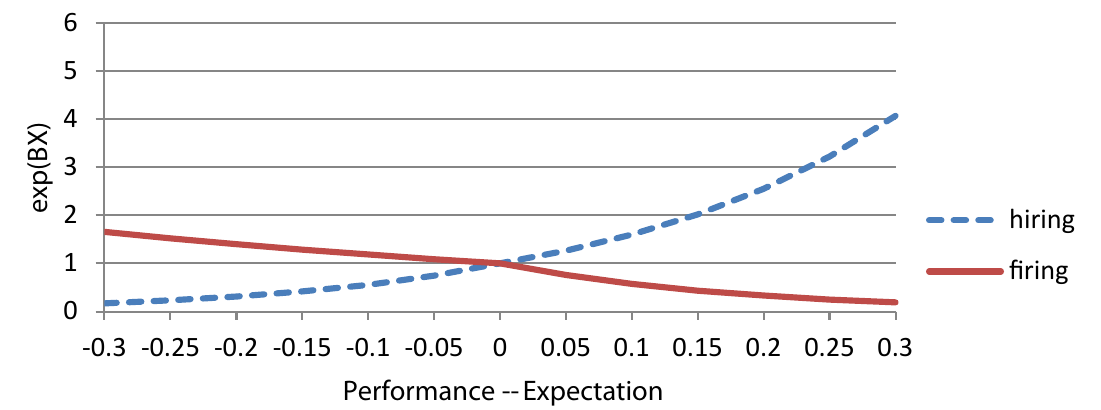
Figure 4. Estimated hazard multipliers for performance relative to